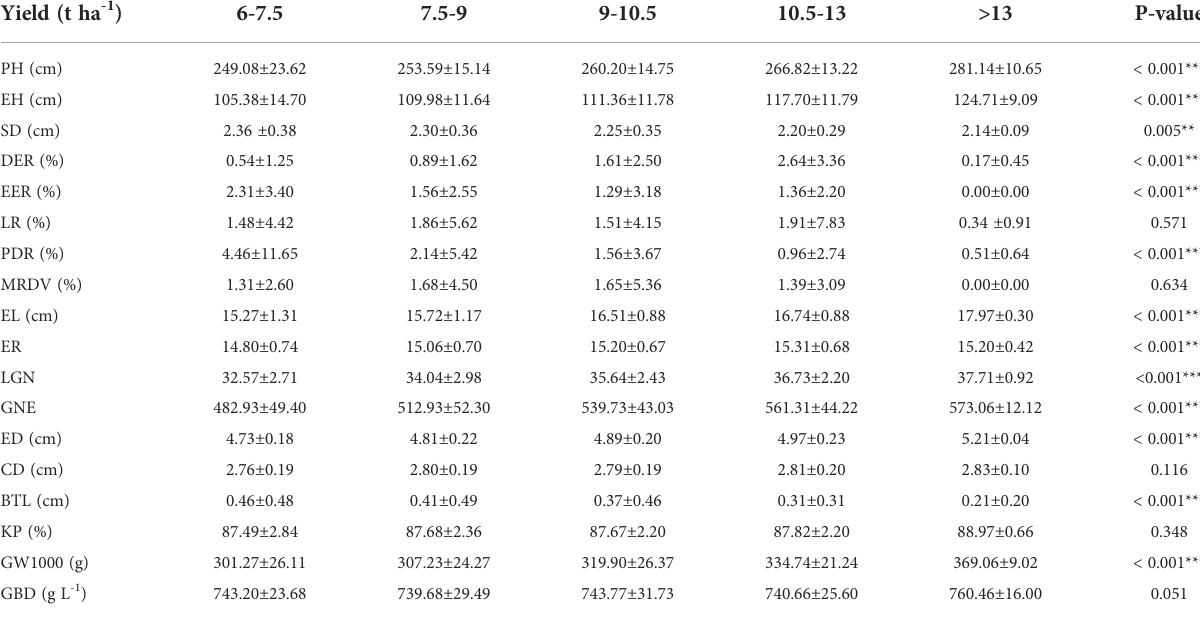
TABLE 3 Agronomic traits of plants at different yield